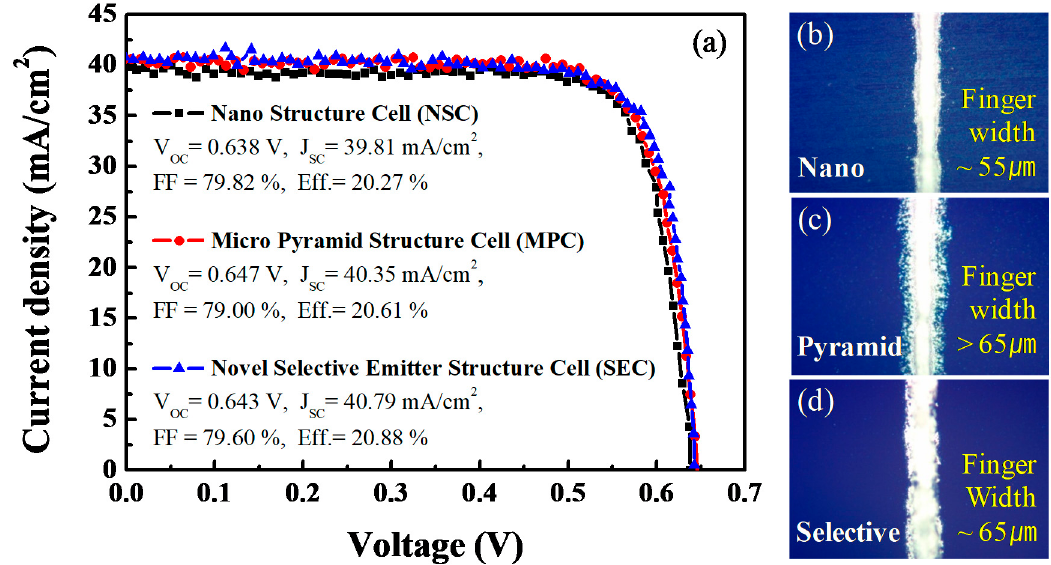
Figure 8. Light density–voltage (J–V) characteristic analysis of crystalline silicon (c-Si) solar cells according to surface morphology and printed front Ag electrode shape, ( a ) result of light J–V, ( b ) optical microscope (OM) image of printed front Ag electrode shape on nanostructured solar cell surface, ( c ) OM image of printed front Ag electrode shape on micro-pyramid-structured solar cell surface, ( d ) OM image of printed front Ag electrode shape on the novel SE-structured solar cell surface.